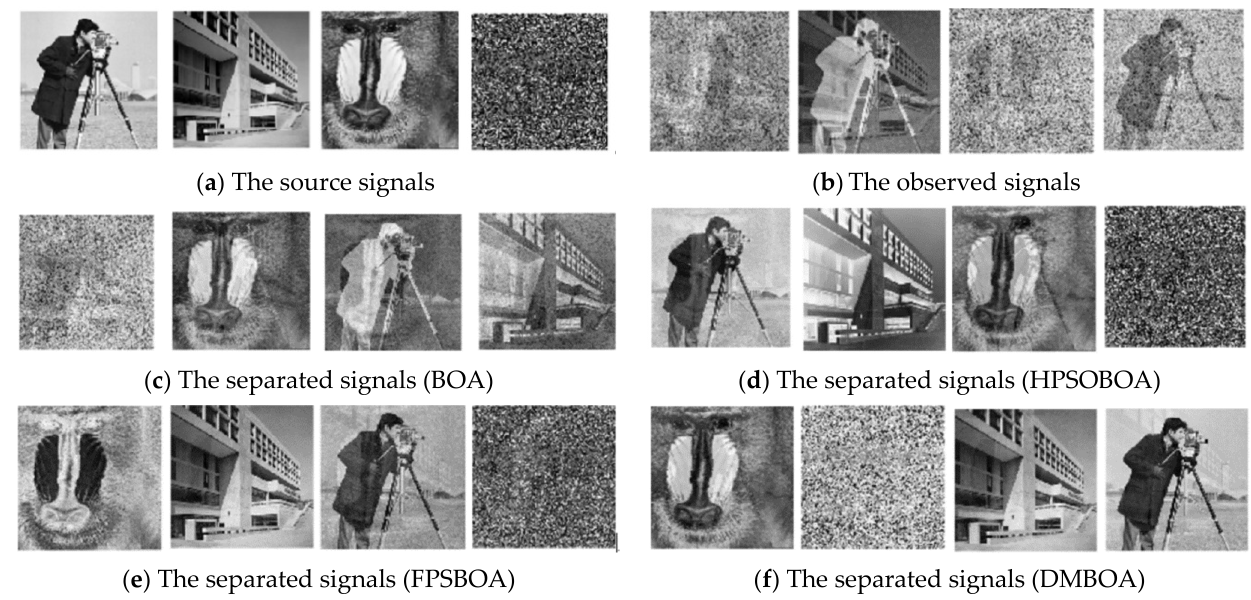
Table 5. Data of image signal separation performance evaluation index.